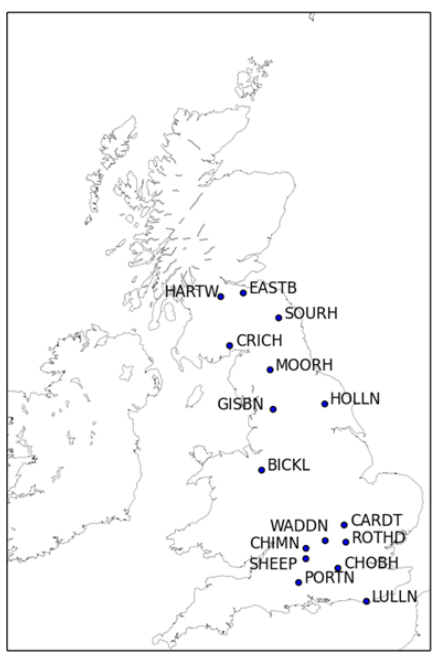
Figure 1. Locations of COSMOS-UK sites used in this